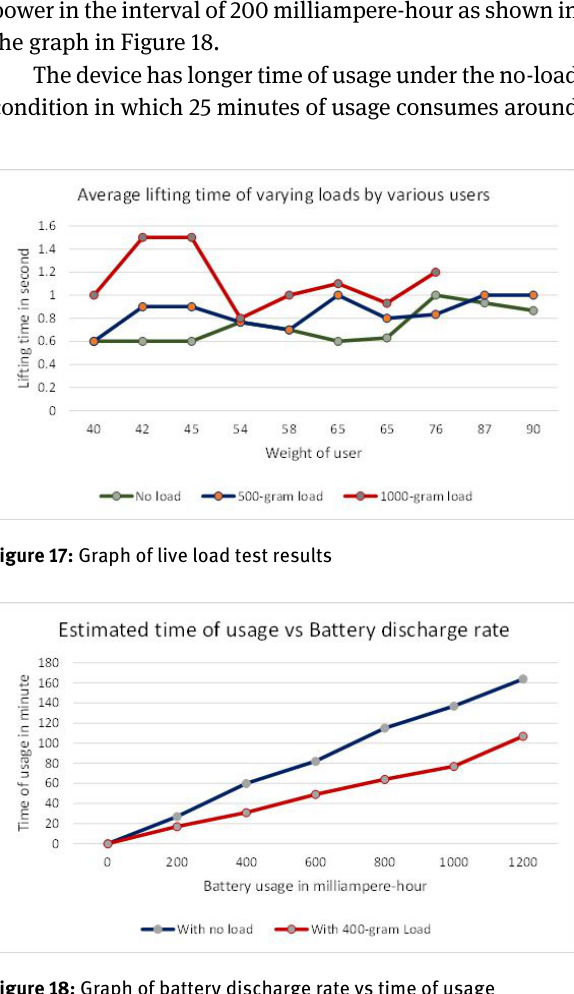
Figure 18: Graph of battery discharge rate vs time of